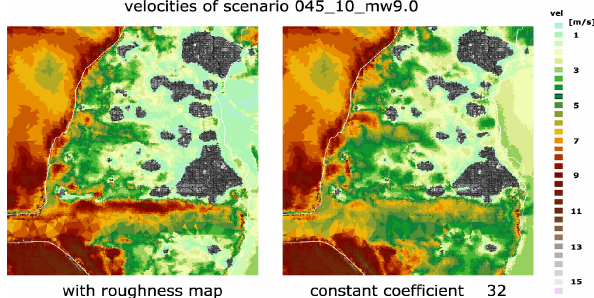
Fig. 7. Maximum velocities for the same scenario as in Fig. Figure 7: Maximum velocities for the same scenario as in figure 6.